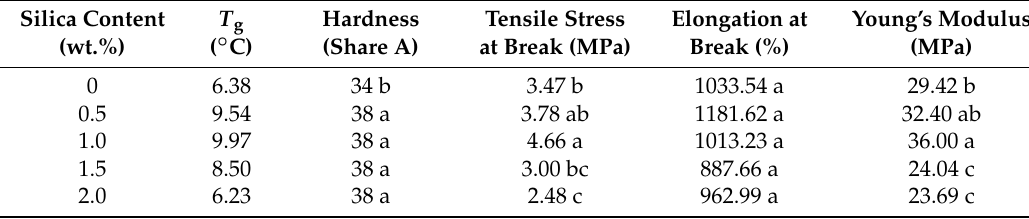
Table 2. Glass-transition temperatures and mechanical properties of